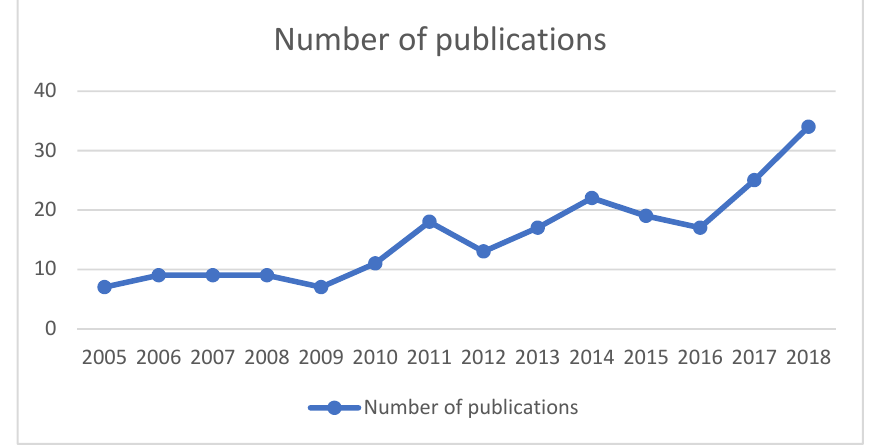
Figure 2. Publications from 2005 until 2018 (217 publications included) *. * Year 2019 and 2020 were excluded from the graph since the review was carried out at the beginning of 2020.